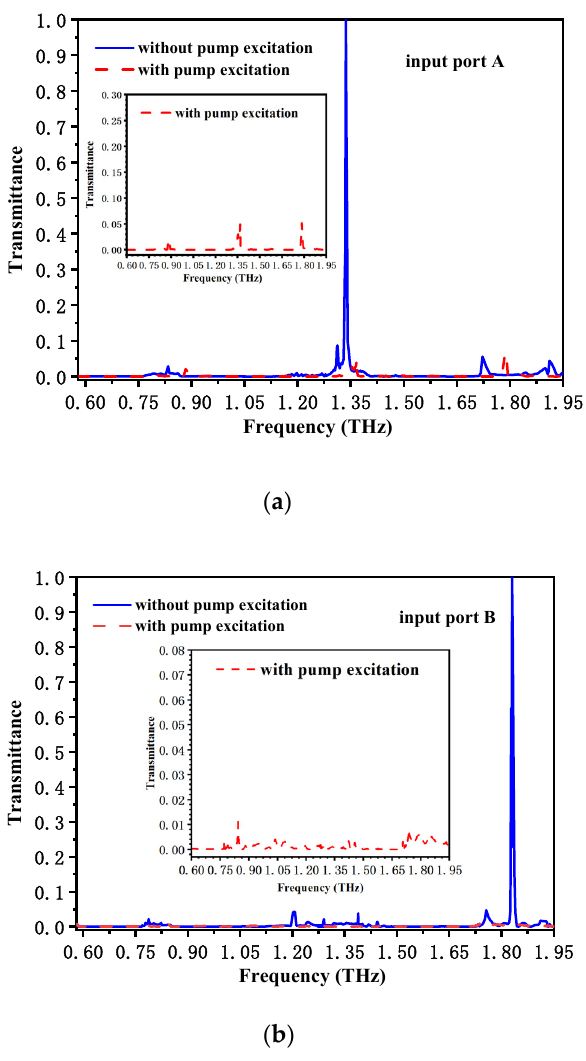
Figure 3. ( a ) Transmittance spectrum of modulator from input port A in TE mode with (dashed line) and without pump excitation (solid line). ( b ) Transmittance spectrum of modulator from input port B in TE mode with (dashed line) and without pump excitation (solid line).